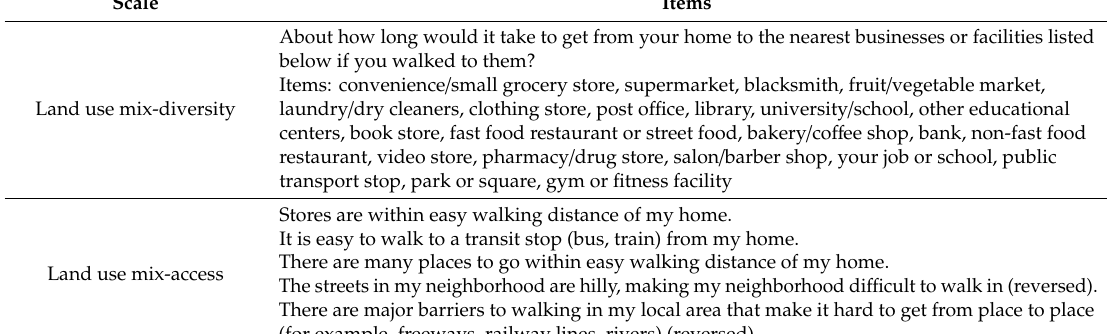
Table 1. Summary of environmental scales,